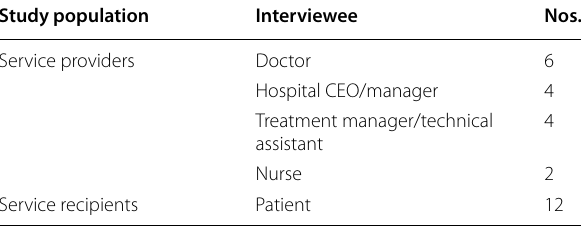
Table 1 Demographic characteristics of the study participants Study population